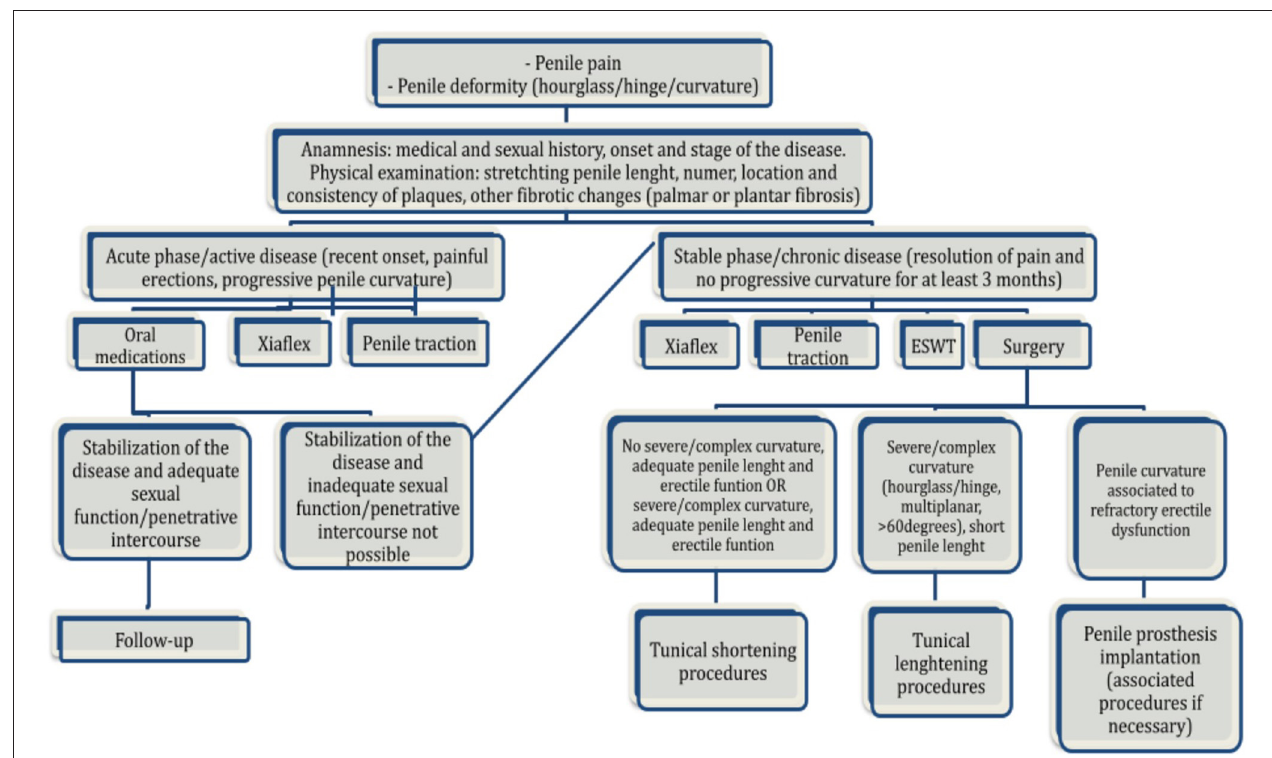
FIGURE 5 | Algorithm for management of Peyronie’s